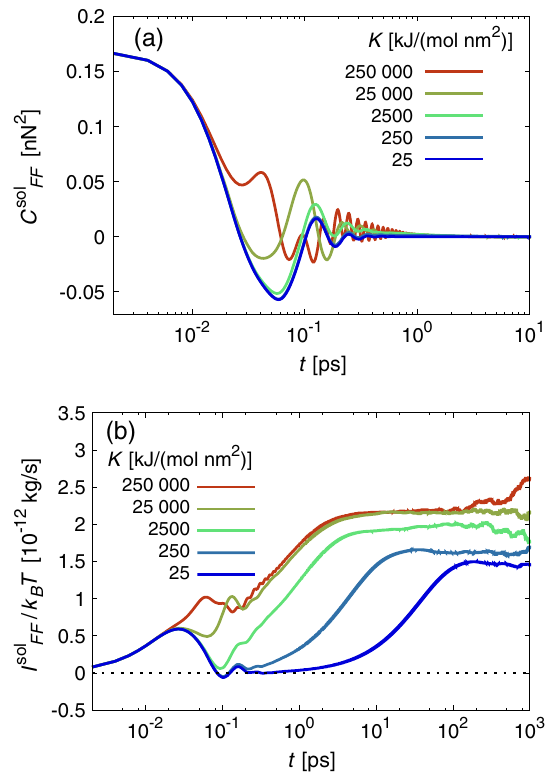
FIG. 9. Simulated autocorrelations for water in water. (a) Solvent-force autocorrelation functions C sol ð t Þ for a confined water molecule for different potential grals I sol FF strengths K